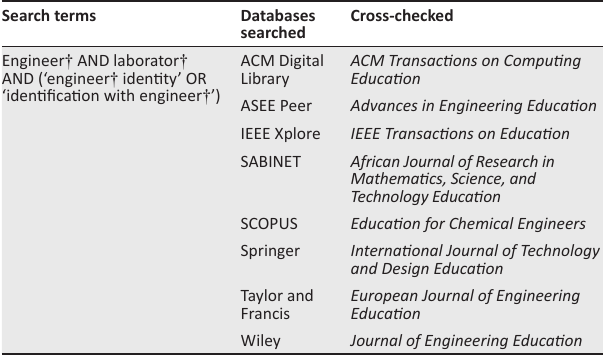
TABLE 1: The search